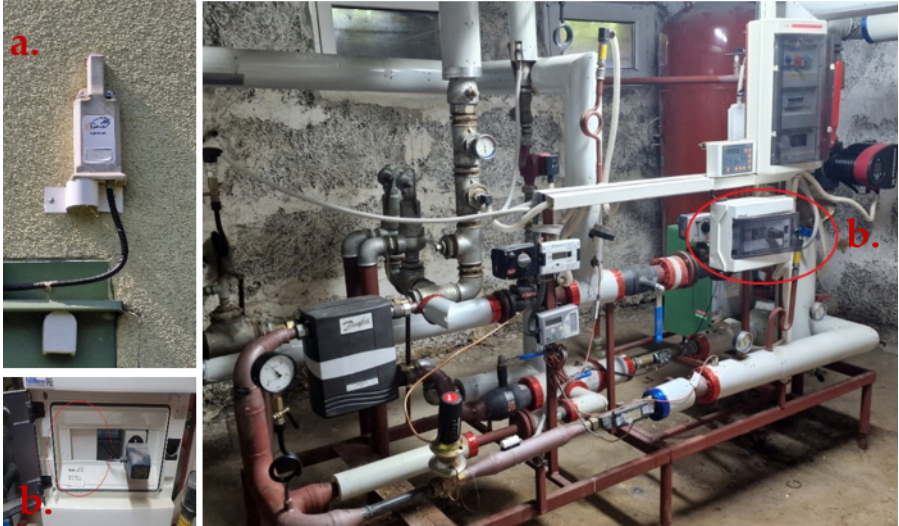
Figure 4. Egain Hub weather forecast receiver ( a ) mounted on the outside wall of the building and the signal transmitter ( b ) mounted on the heating substation [photo taken by authors].